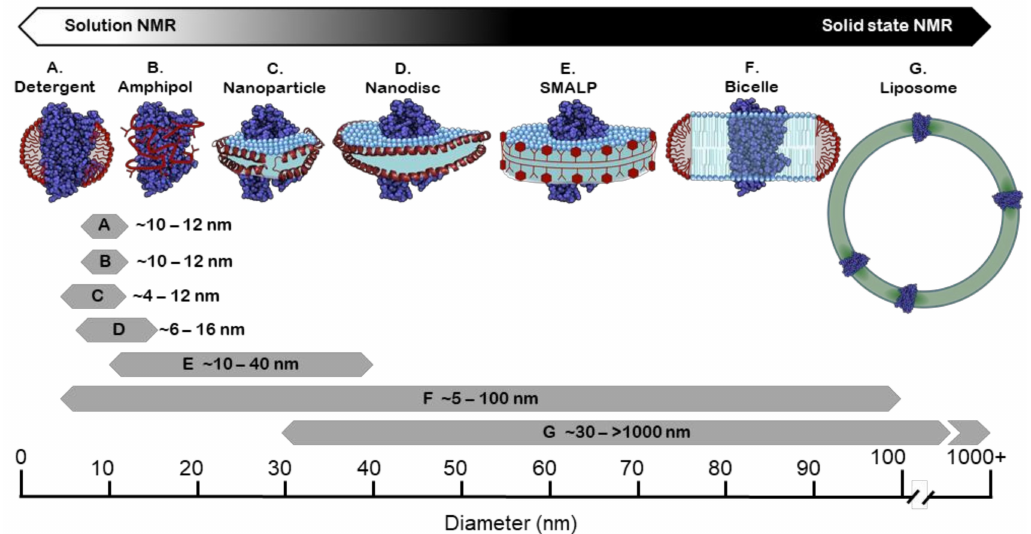
Figure 4. Cartoon representation of frequently used membrane mimetics with an embedded GPCR. With the exception of the Liposome ( G ), the individual mimetic systems are displayed to scale ( A – F ). For each system, approximate size ranges are indicated below the individual cartoons. For the non-bilayer-forming mimetics such as detergent micelles ( A ) and amphipols ( B ), size ranges are based on the incorporation of a class A GPCR in LMNG or DDM [216,217], or the A8-35 amphipol [218,219]. The structures for saposin A ( C ), MSPD1 ( D ) and t β 1 AR ( A – G ) were modified from PDB accession codes: 4DDJ, 6XBD, 4BVN,